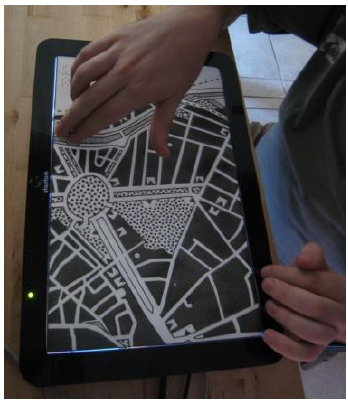
Figure 2. Touch the map! allows blind users to interact with a tactile map and retrieve names, distances and details using gestural interaction technique. Retrieved from (A. Brock et al.,